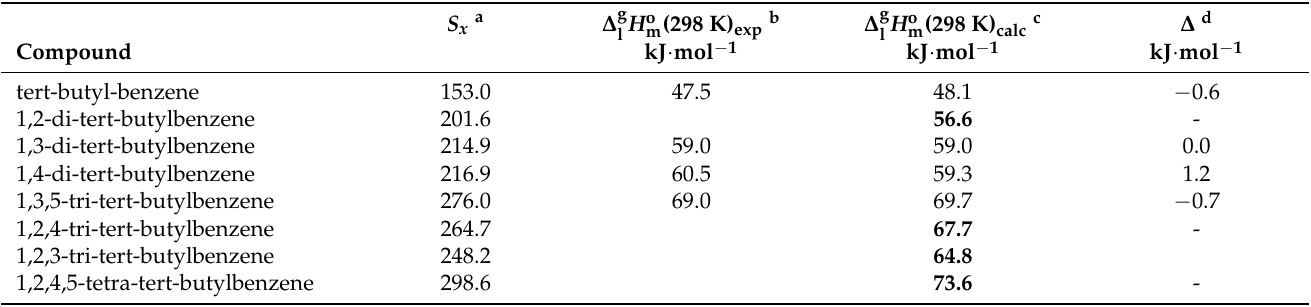
Table 7. Correlation of the vaporisation enthalpies, ∆ g benzenes with their solvent-accessible surfaces ( S x